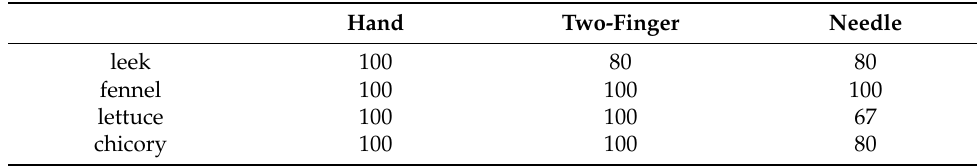
Table 1. Transplanting success rates by percent.